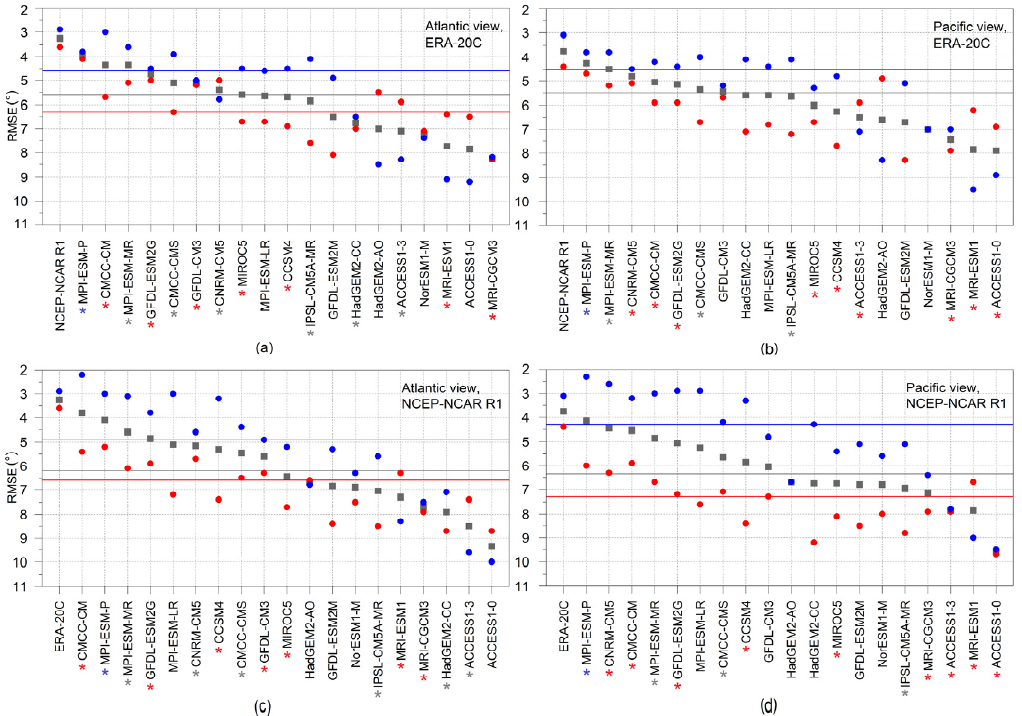
Figure 8. Comparison of the GCM loess regression curves with the reanalysis based loess regression curves on maps with the Atlantic view ( a , c ) and on maps with the Pacific view ( b , d ). The ERA-20C is used as a reference dataset in ( a , b ), while the NCEP-NCAR R1 is used in ( c , d ). Blue and red dots represent RMSE values represented by the northerly and the southerly poles, respectively, while grey squares indicate the average RMSEs. Red, blue, and grey straight lines denote the median GCM-performance (expressed by RMSE). GCMs with an EV at least around 50% are denoted with red, blue, and grey asterisks with respect to the southerly poles, the northerly poles and both poles of the PotACs, subsequently. The GCMs are ranked in decreasing order according to average RMSE values.